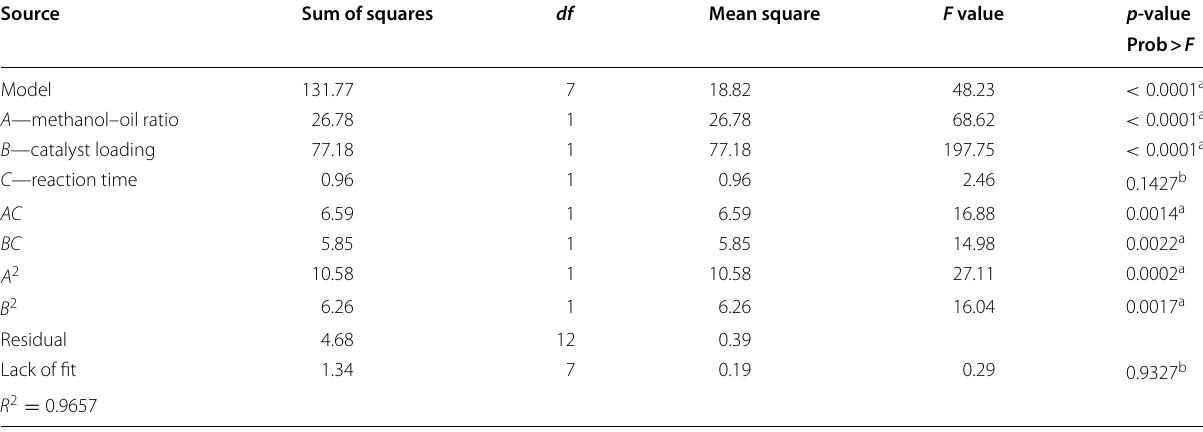
Table 6 ANOVA of the reduced quadratic model of oil yield from WO-RP